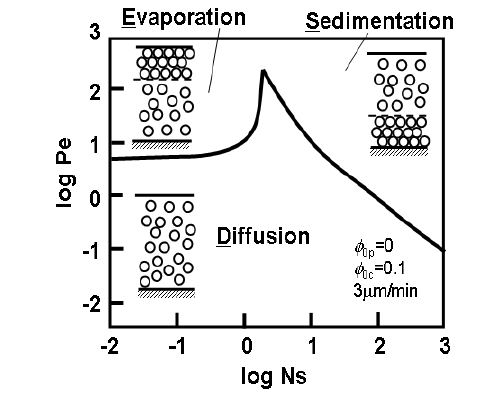
Fig. 4 Variations in particle distribution as a function of Peclet number (Pe) and sedimentation number (Ns) 22) .